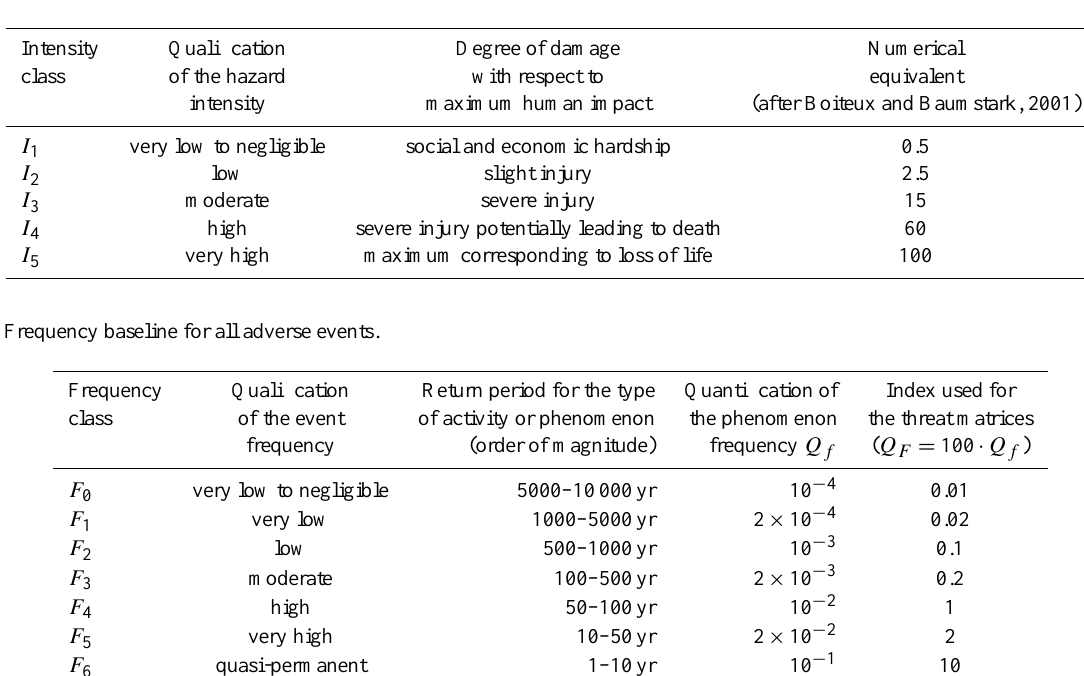
with respect to